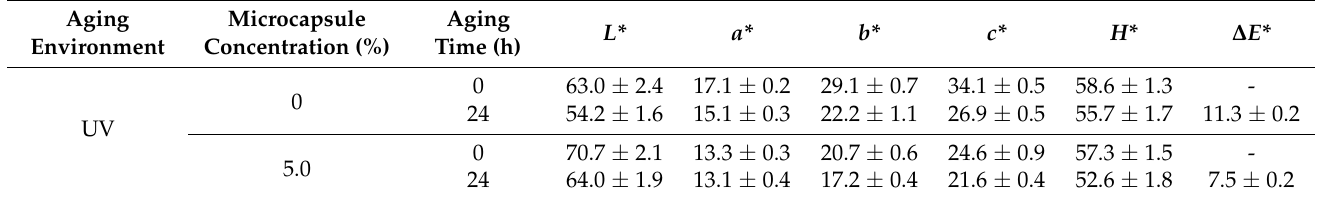
Table 9. Color difference after UV